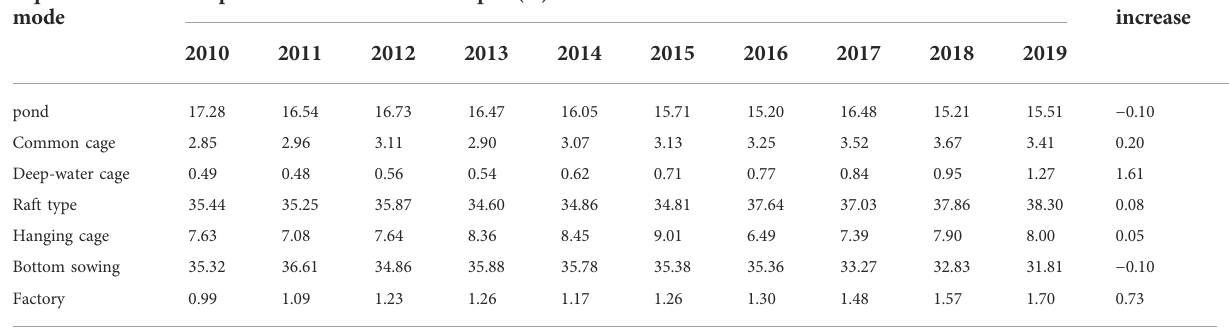
TABLE 5 Aquaculture mode from 2011 to 2019.